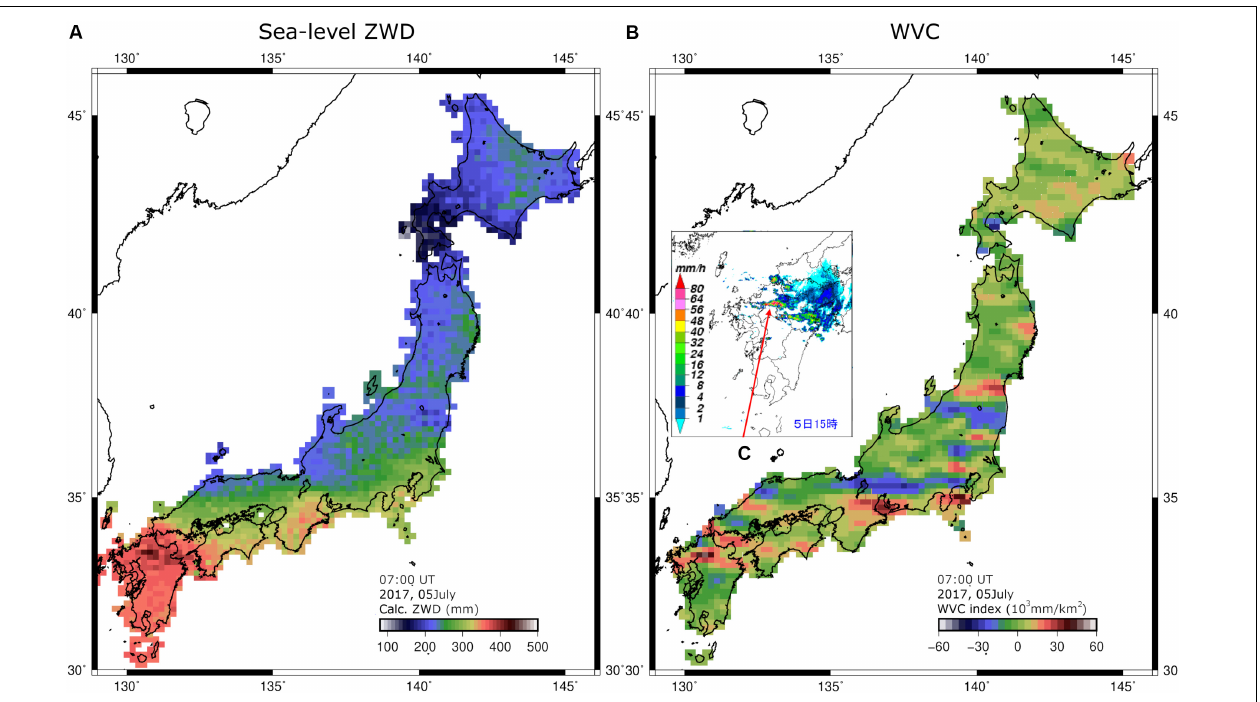
FIGURE 6 | Estimated sea-level ZWD (A) and WVC (B) at 07 UT (16 JST) on July 5, 2017. (C) shows the rain rate map from Japan Meteorology Agency [JMA] (2017) at the epoch 1 h earlier (06 UT) than (A,B) .